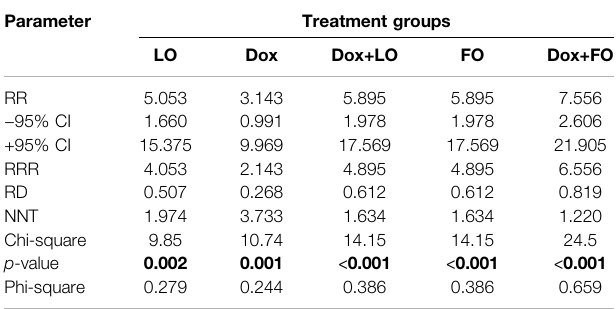
The values of p < 0.05 are highlighted in bold, which indicates statistically signi fi cant differences between the experimental and control groups. RR, Relative risk; RRR, Relative risk reduction; RD, Risk difference; NNT, Number needed to treat; Chi-square, Yates corrected Chi-square; − 95% CI, Lower limit (95% con fi dence interval); +95% CI, Upper limit (95% con fi dence